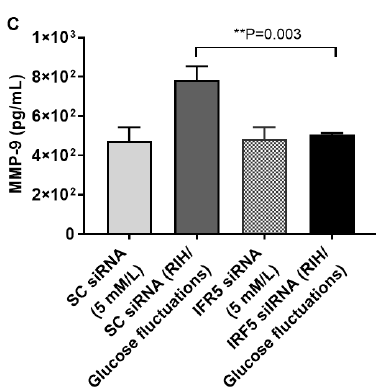
Figure 5. Repetitive intermittent hyperglycemia (RIH) induces IRF5-dependent expression of matrix metalloproteinase (MMP)-9 in THP-1 macrophages. THP-1-derived macrophages grown on coverslips were cultured for 3 days under conditions of hypoglycemia (3 mM/L), normoglycemia (5 mM/L), persistent medium hyperglycemia (15 mM/L), and RIH/glucose fluctuations (3–15 mM/L). MMP-9 intracellular expression and MMP-9 secreted protein in culture supernatants were determined by confocal microscopy and ELISA, respectively, as described in the Materials and Methods section. In IRF5 silencing assays, THP-1 monocytes were transfected with scrambled siRNA (mock/negative control) or IRF5 siRNA and incubated for 36h. Later, THP-1 transformed macrophages were cultured for 36 h under conditions of normoglycemia (5 mM/L) and RIH/glucose fluctuations (3–15 mM/L), and supernatants were collected for measuring MMP-1 secreted protein expression by ELISA. ( A ) Representative ELISA data from three independent determinations with similar results are presented as bar graph of MMP-9 secreted protein expression (pg/mL) in culture supernatants. ( B ) Representative images from five independent determinations with similar results, showing MMP-9 protein expression in macrophages cultured under various glucose concentration in the medium. Images are shown at 40× magnification; Scale bar = 20 µM. ( C ) Representative ELISA data from three independent determinations with similar results are presented as bar graph showing MMP-9 secreted protein expression (pg/mL) in supernatants of macrophages cultured under normoglycemia and RIH/glucose fluctuations, with or without IRF5 silencing. All data are expressed as mean ± SEM values. ** P ≤ 0.01, *** P ≤ 0.001, and NS: nonsignificant.